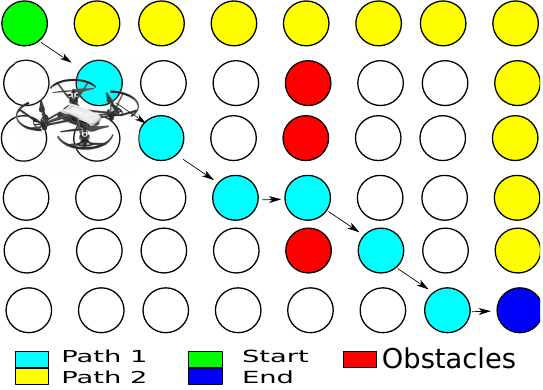
Figure 6. Path planning description using A ∗ algorithm.